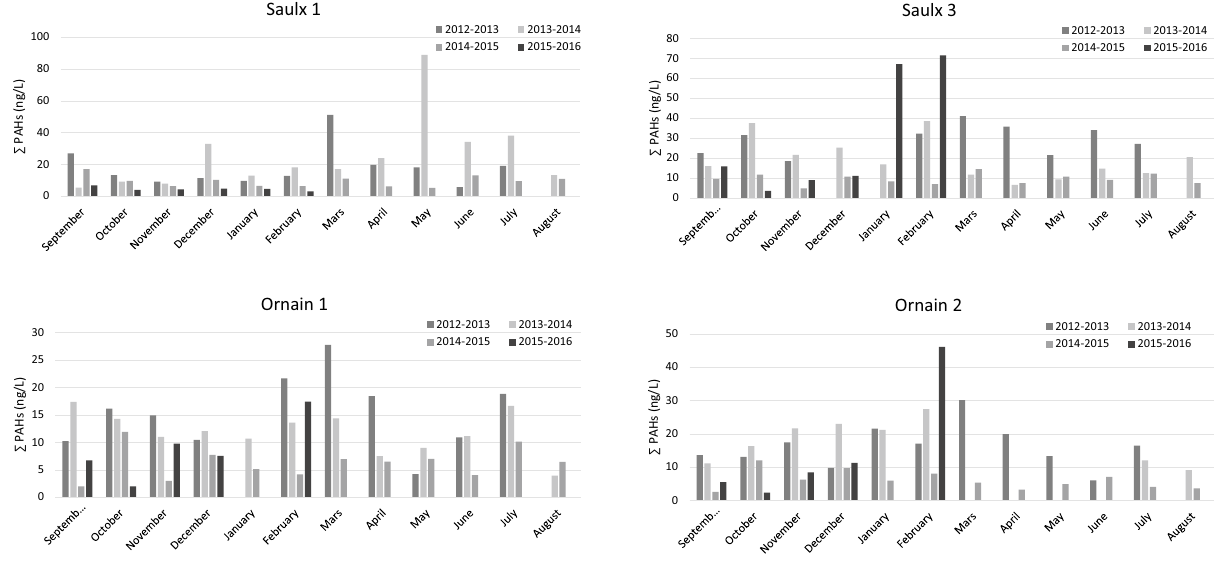
Fig. 6 Sum of PAHs TWA (FLU, PHE, ANT, FLR, PYR, BaA, CHY, BbF) at the upstream and downstream monitoring stations on the Saulx (top) and Ornain (bottom) Rivers, from September to August of each year of monitoring using passive samplers